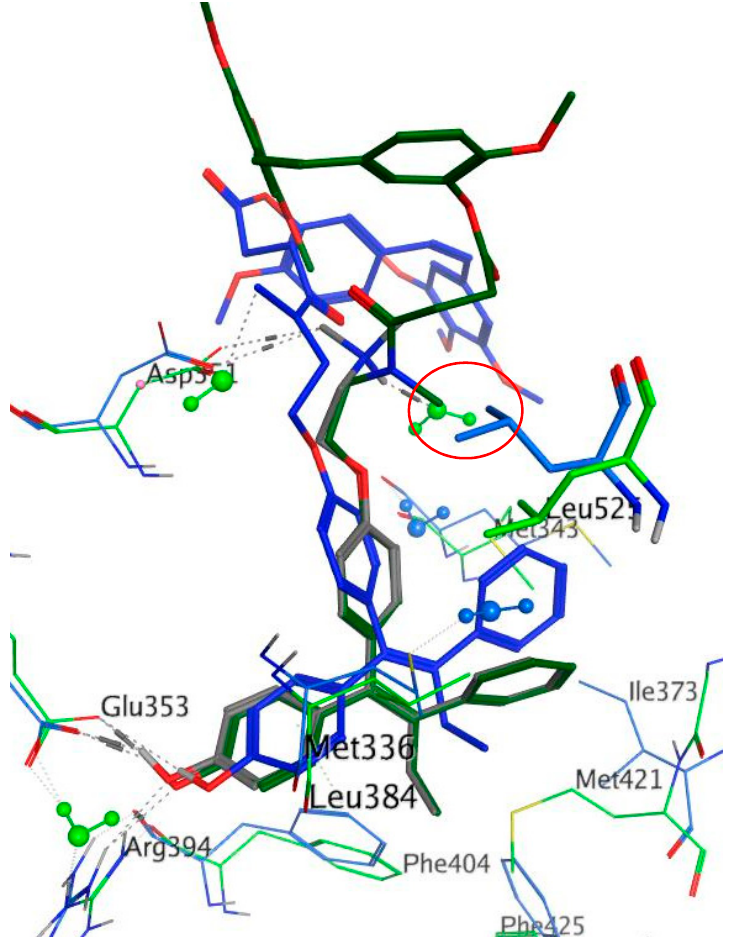
Figure 5. Ranked poses of 16b in ER α and ER β overlaid on 4-OHT X-ray structure. The potential clashing interaction between Leu525/476 (rendered in tube style) of ER β with the methylamide of 16b is circled in red. Carbon atoms of 16b are illustrated in dark green in ER α , dark blue in ER β and grey in 4-OHT (oxygen atoms are red; nitrogen in dark blue; sulphur in yellow). ER α and associated water molecules are in light green, ER β and associated water molecules are in light blue. Amino acid numbering is for ER α except when different in ER β where both labels are used. PDB structures 3ERT [69] and 1NDE [70] were used for molecular docking.